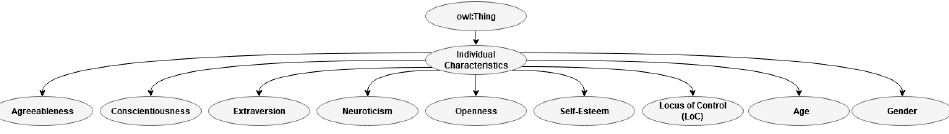
Figure 6. Class individual characteristics.